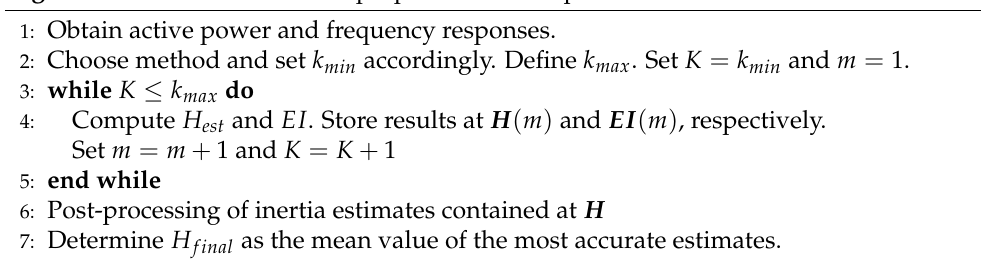
Algorithm 2 Pseudocode of the proposed iterative